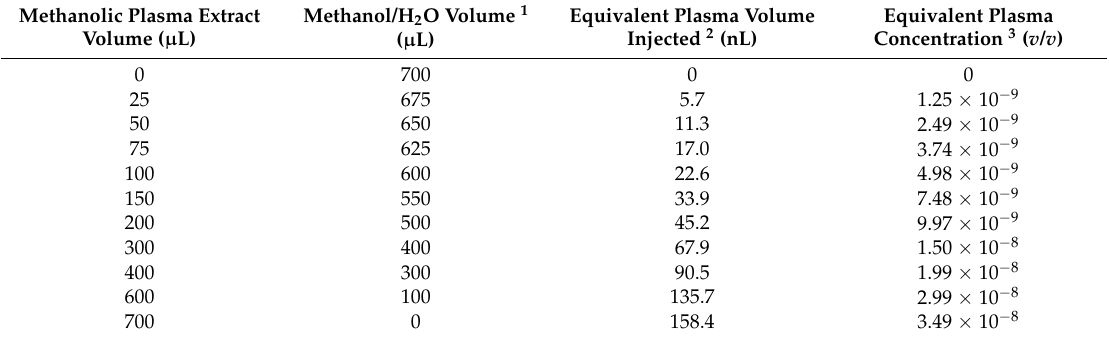
Table 4. Experimental design for each batch in the limiting-dilution study. Eleven different plasma extract volumes repeated three times were included in each batch (total number of aliquots = 33). Each plasma extract volume was ballasted with 7.5:1 methanol/H 2 O ( v / v ) to bring the total volume to 700 µ L. The entire limiting-dilution study consisted of 10 batches with identical experimental